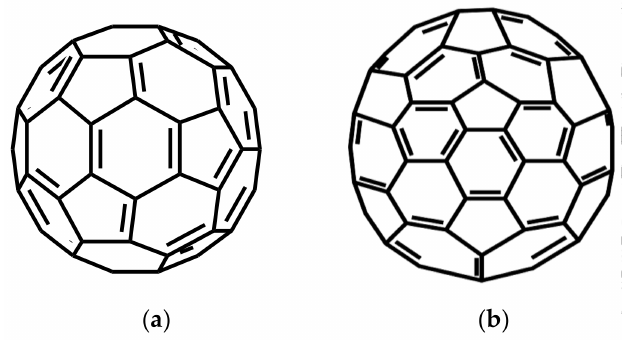
Figure 3. ( a ) Shape of fullerene C 60 , also known as buckyball, and ( b ) fullerene C 70 . As clearly evident, not all fullerenes are characterized by the same